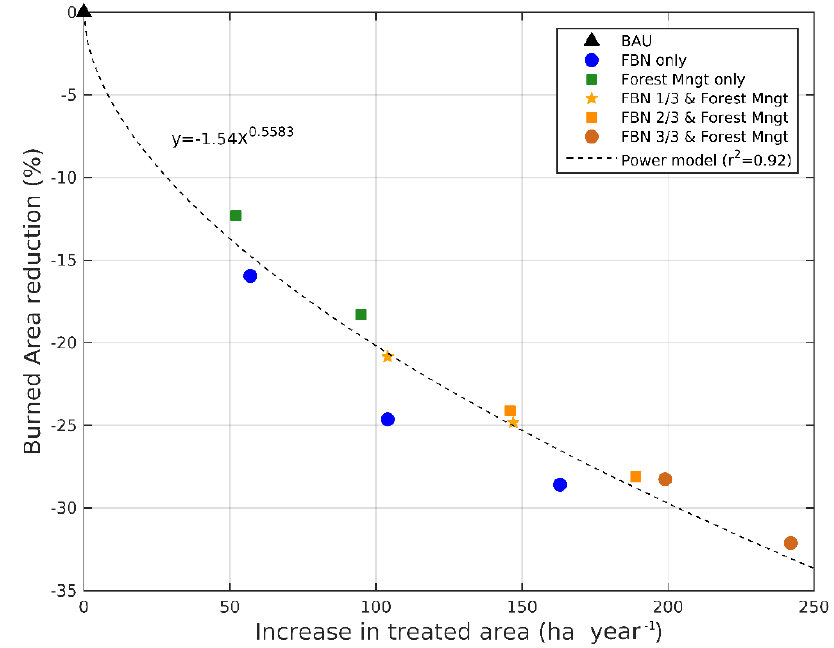
Figure 12. Comparison between burned area reduction (%) and increase in the area annually treated area (ha). The dashed line represents the power model adjusted to the data. X in the equation is the “increase in treated area (ha year − 1 )” variable.